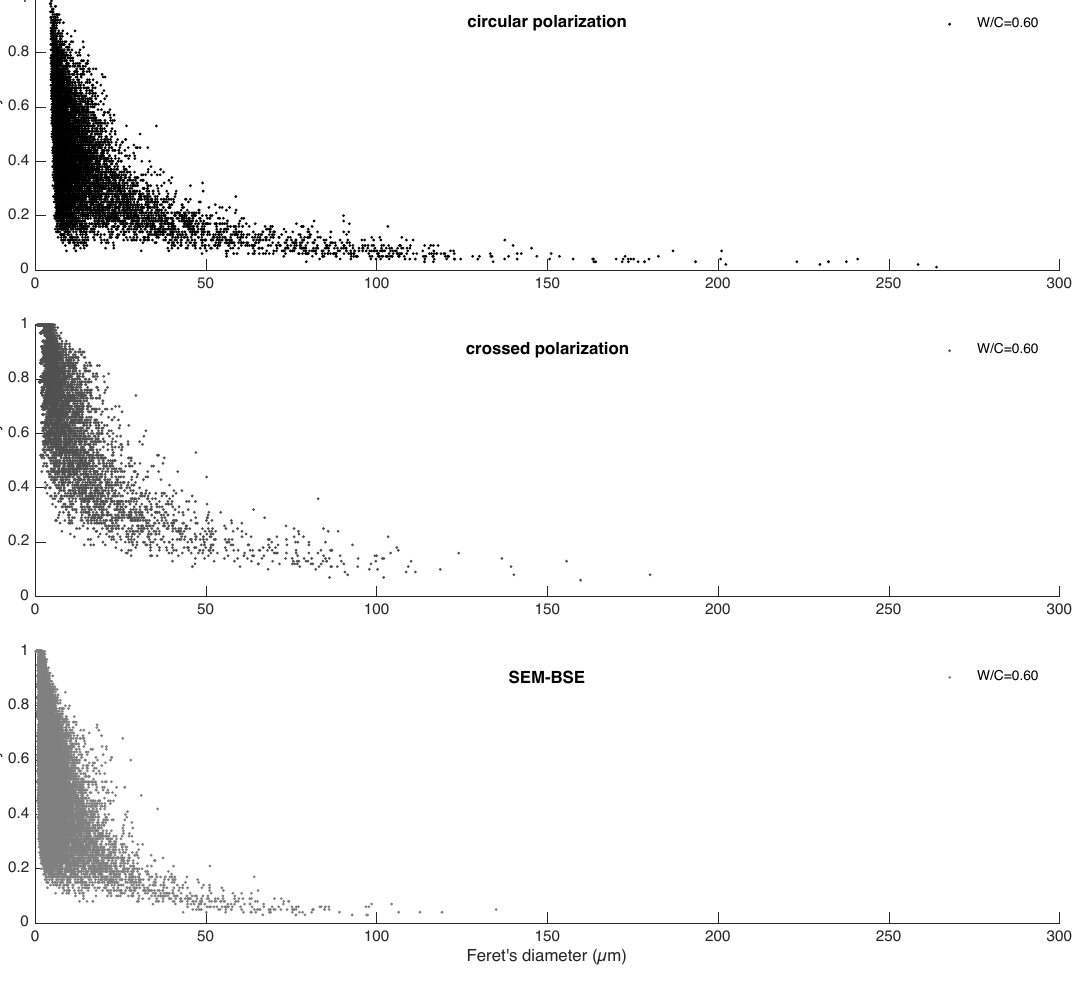
Figure 5. Micromorphological features of the portlandite clusters in OPCpaste with a W/C = 0.60; circularity versus Feret’s diameter. Based on circular polarization; crossed polarization; and SEM-BSE